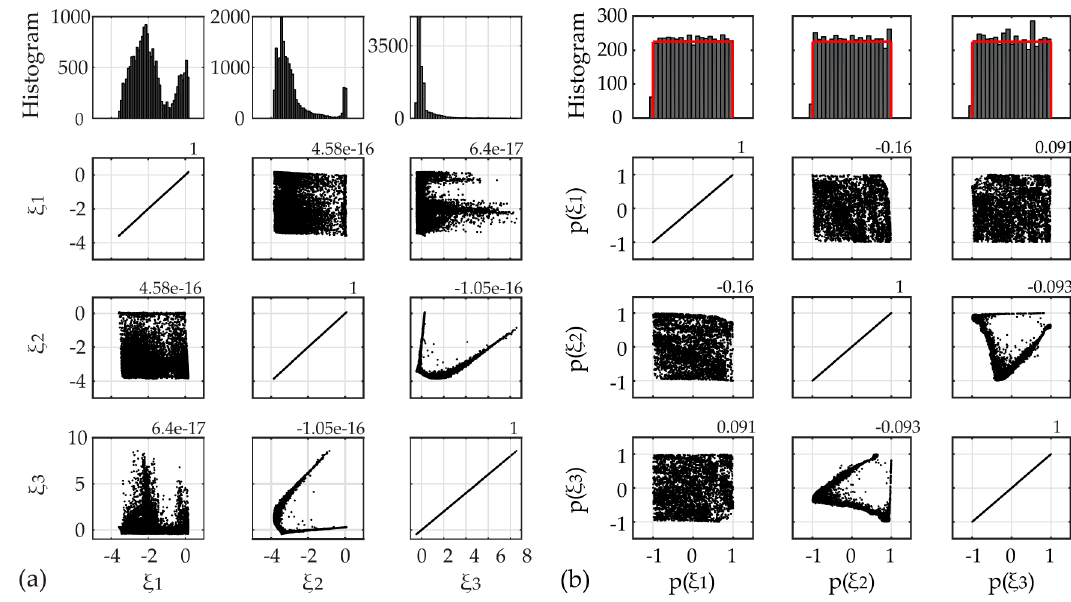
Figure 15. Input data for Case B: ( a ) Scatter plots of ICA-based input variables and estimated correlation values, histograms of the latent variables (upper row); ( b ) Scatter plots of the random vector Ξ of prescribed uniform PDF p Ξ ( ξ ) , histograms of the random vector Ξ values (upper